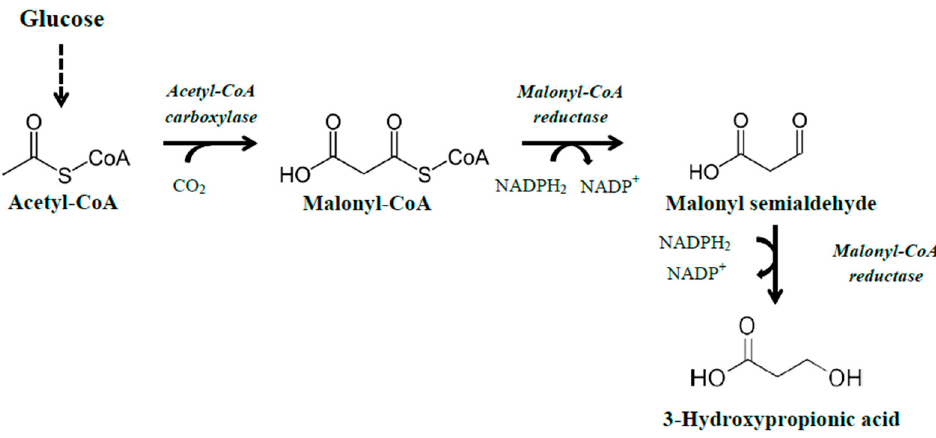
Figure 3. Conversion of glucose to 3HP through the malonyl-CoA pathway.